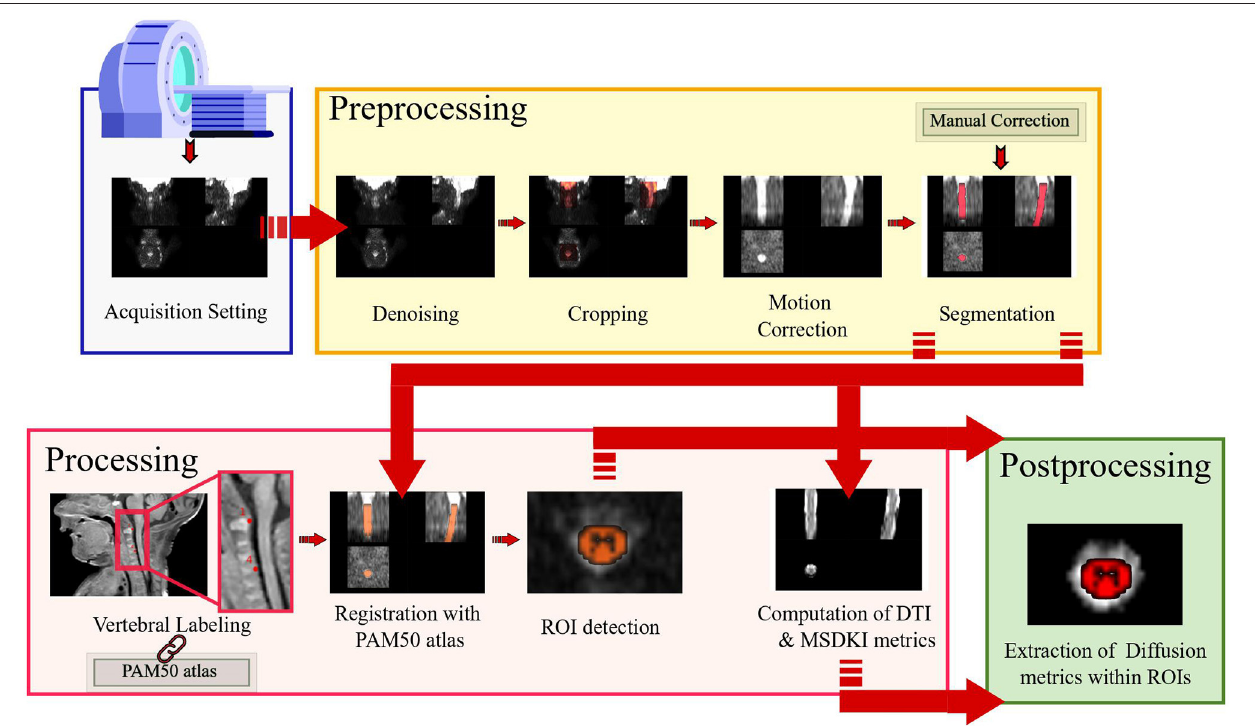
FIGURE 1 | Overall processing pipeline: the designed pipeline allows complete handling of diffusion kurtosis imaging scan of neonatal spinal cord from acquisition setup to preprocessing, processing, and postprocessing.